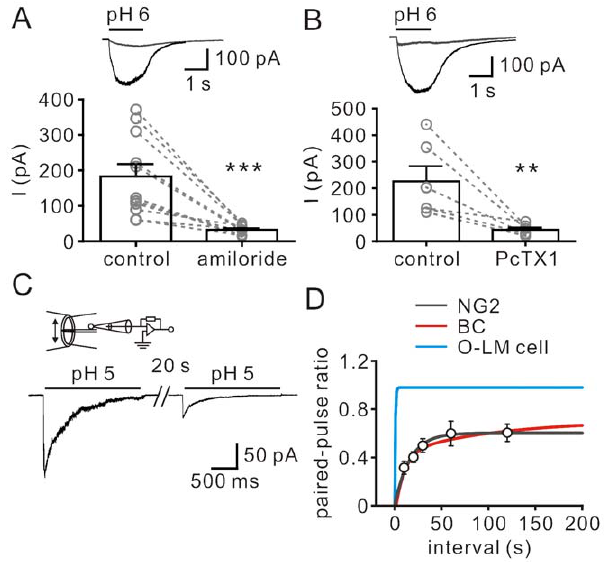
Figure 4. Pharmacological profile and gating of ASICs in NG2 cells. (A) Top, ASIC currents evoked by pH 6 in the control (black) and by co-application of pH 6 and 100 m M amiloride (gray). Traces in the control and in the presence of amiloride were obtained from the same cell. Bottom, summary of the effect of amiloride on ASIC currents. Data obtained from the same cell were connected by dashed lines. *** P , 0.0005. (B) Top, ASIC currents evoked in the control (black) and after bath addition of PcTX1 (gray). Bottom, summary of the effect of PcTX1 on ASIC currents. ** P , 0.005. (C) Representative ASIC currents in a nucleated patch ( V -clamped at 2 60 mV) evoked by double pulses (2 s, pH 5) separated by 20 s. (D) Recovery from desensitization of ASIC currents. The black curve represents a single exponential function fitted to the data points (pooled from at least 5 cells). ASIC recovery curves from BCs (red) and O-LM cells (blue) (reproduced from [24]).